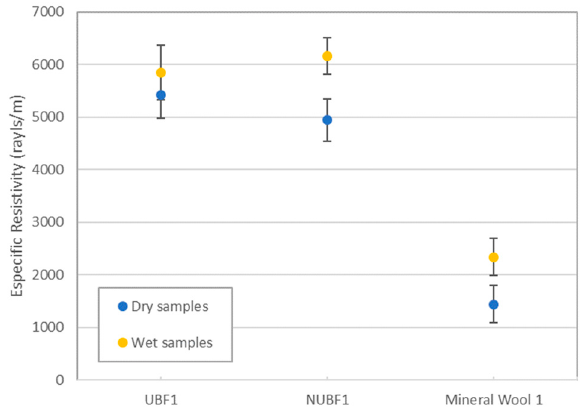
Figure 6. Variation of airflow resistivity of the samples shown in Figure 4.